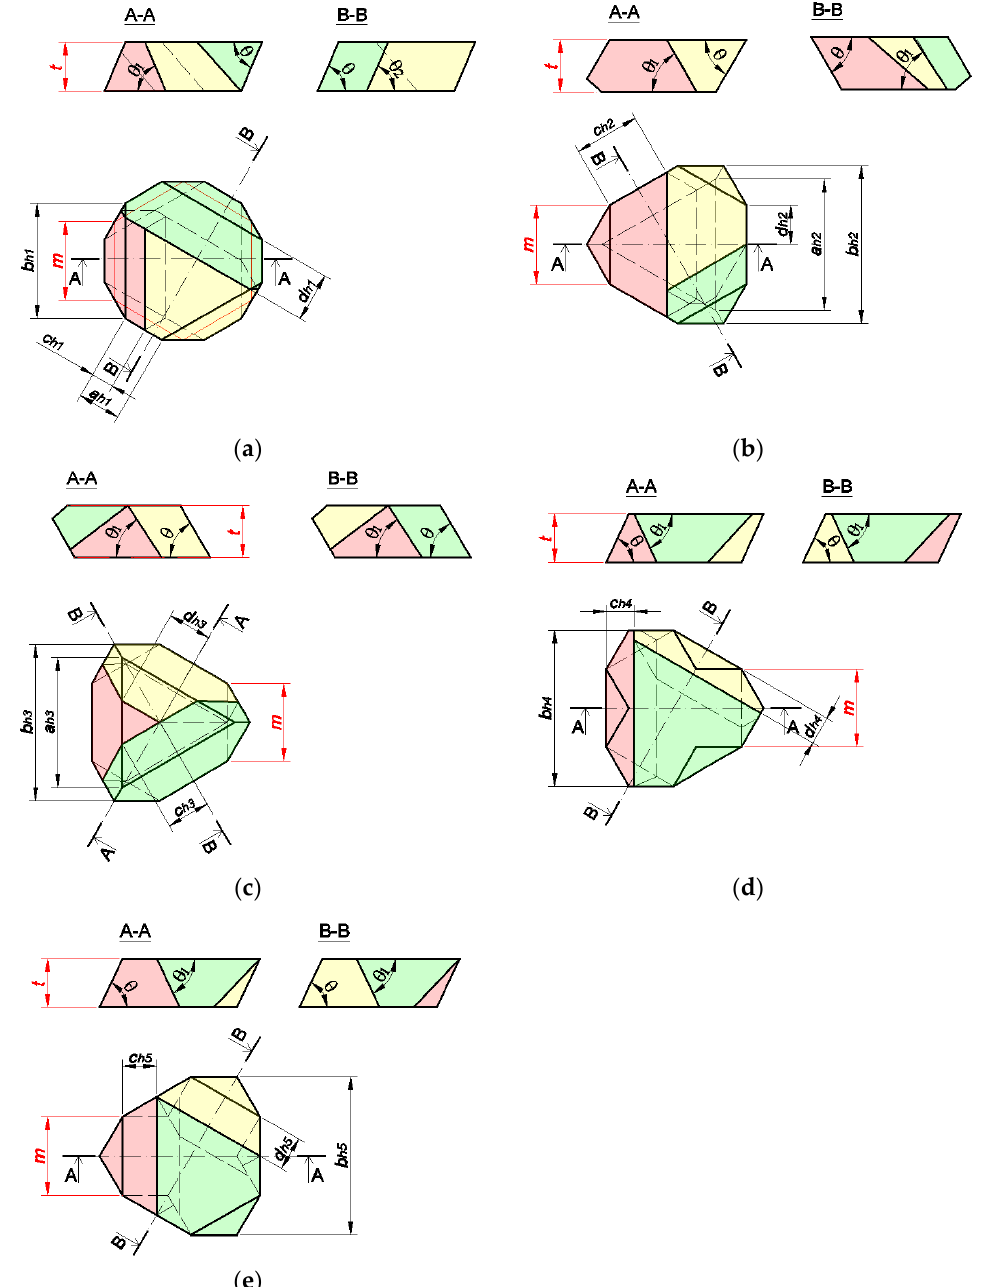
Figure 30. Dimensions of the parts of the hexagonal keystones for use in triangular and hexagonal vaults: ( a ) rough on both sides; ( b ) smooth from above; ( c ) smooth from below; and ( d , e ) both sides smooth.